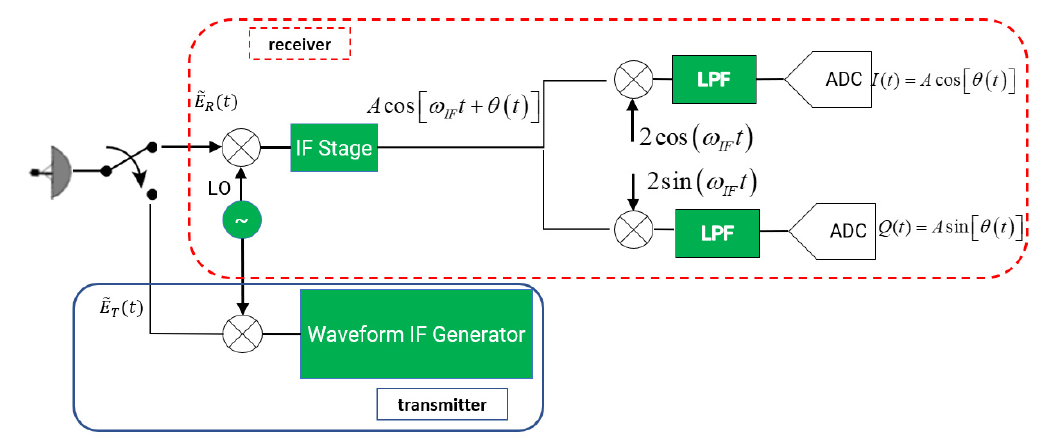
Figure 2. Radar transceiver.